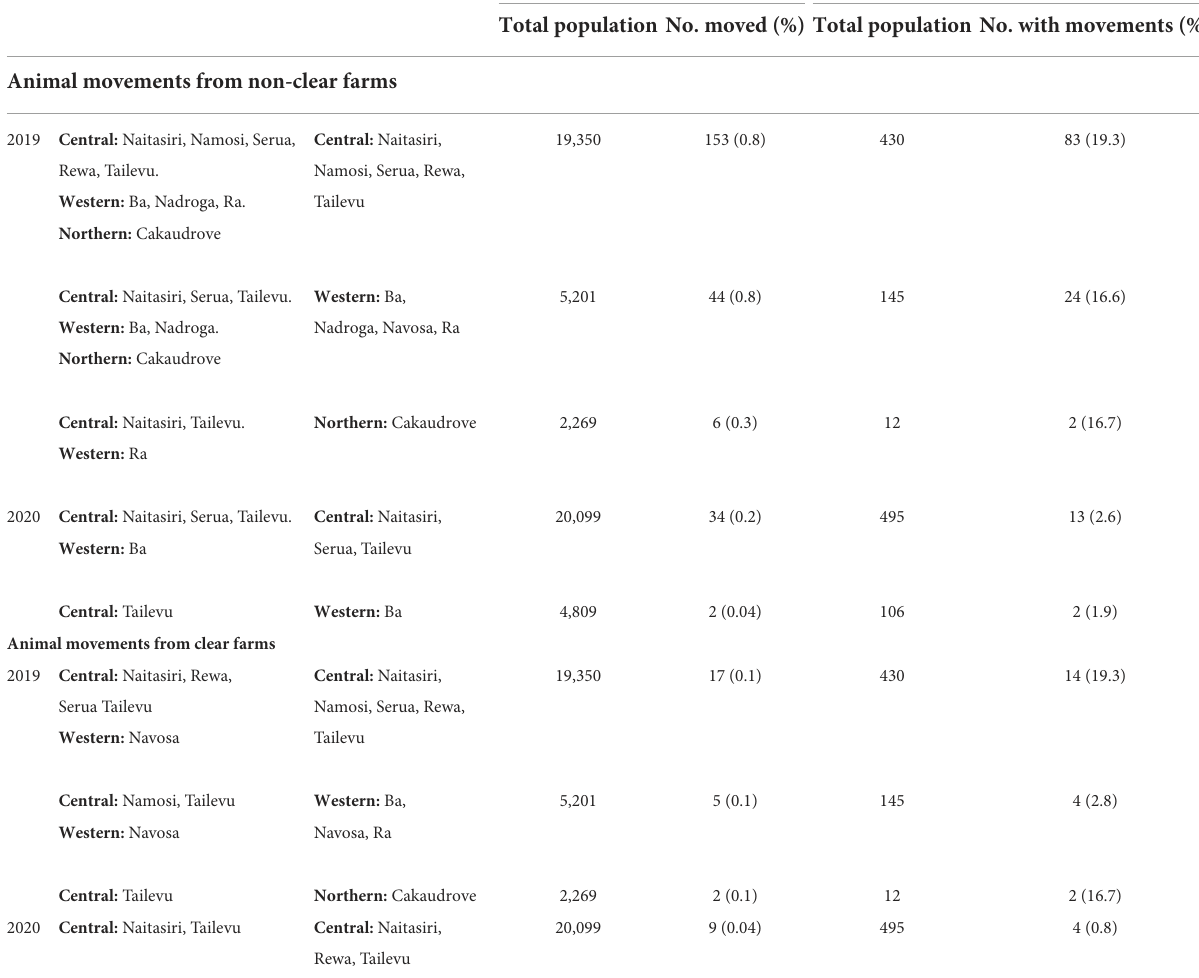
TABLE 8 Animal movements from non-clear farms to a farm in a different province and from clear farms to a farm in a different province during 2019–2020. Movement origin Movement destination Year Division: Province Division: Province Animals tested a Farms tested a Total population No. moved (%) Total population No. with movements (%) Animal movements from non-clear